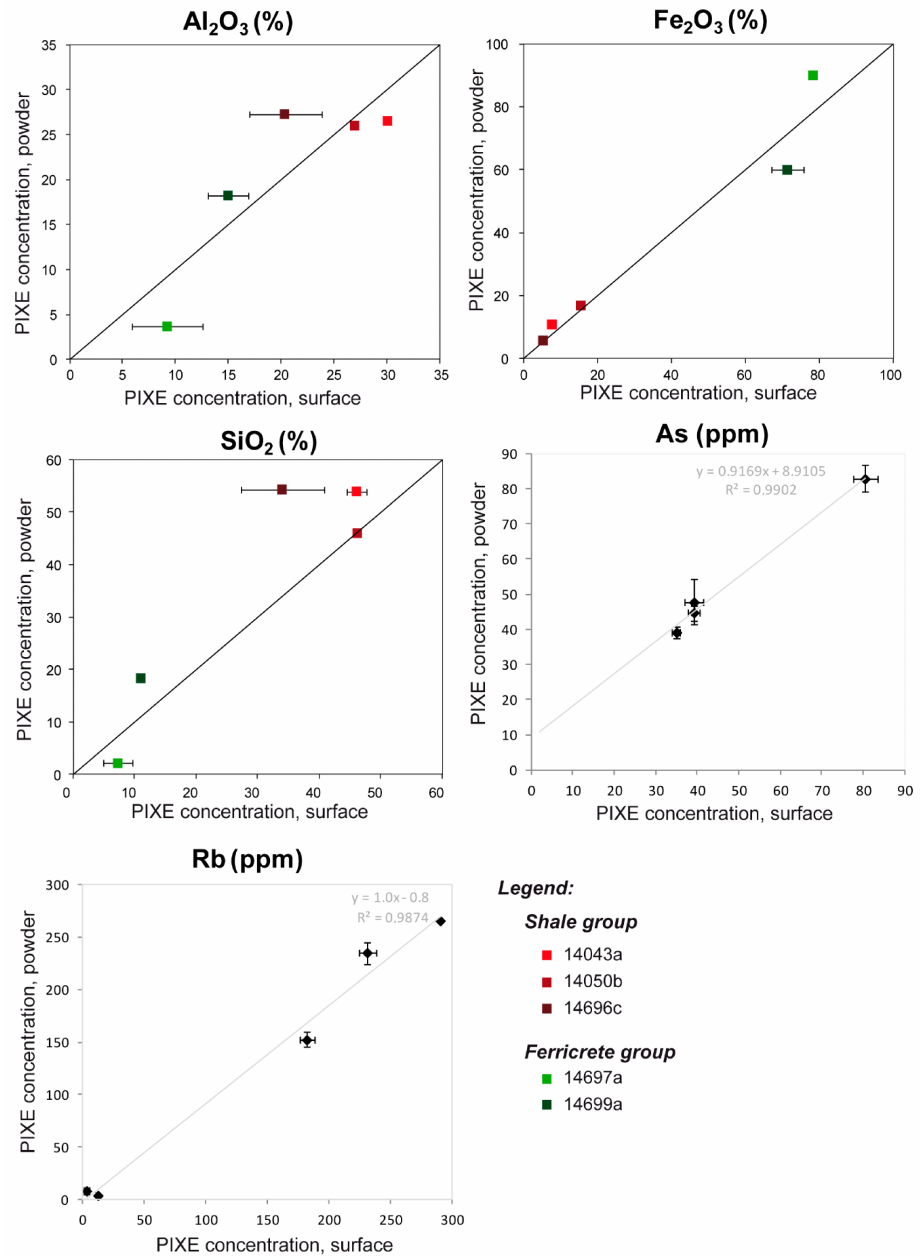
Figure 5. Results of PIXE analyses of cohesive geological pieces (surface) compared with the analysis of pellets (powder) for major elements Al, Si, and Fe, as well as trace elements Rb and